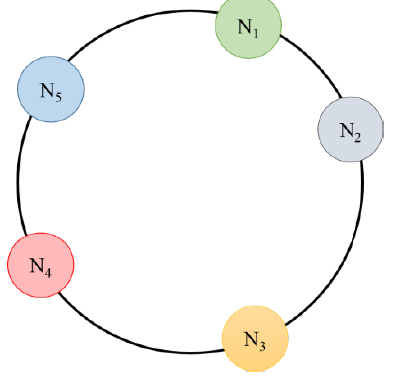
Figure 2. Identifier space of the chord.